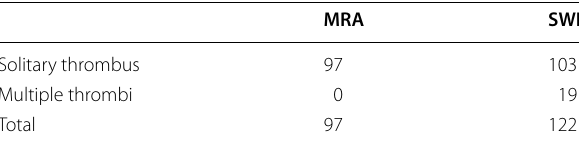
Table 1 SWI versus MRA in detection intra-arterial thrombus Occlusion on MRA